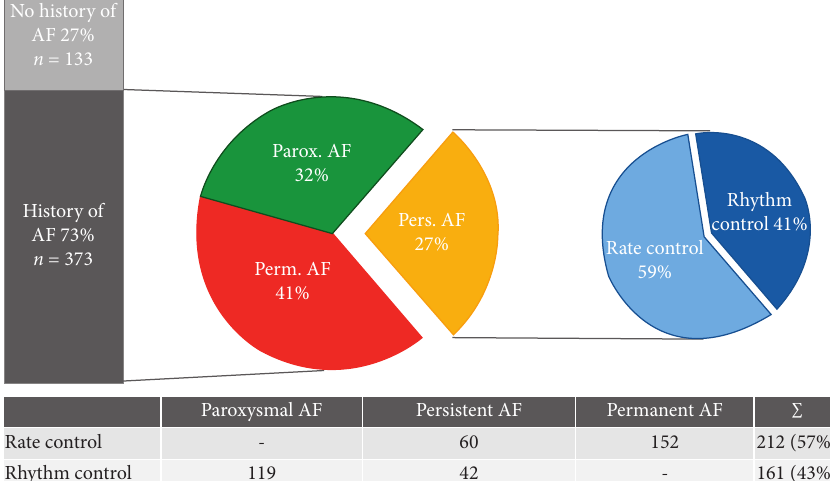
Figure 1: AF type and corresponding treatment regimes. Overview of patients with and without a history of AF, AF types, and cor- responding treatment regimes. AF, atrial fibrillation; Parox., paroxysmal; Pers., persistent; Perm., Table 3: Anticoagulation, CHA 2 DS 2 -VASc score, and AF treatment regimens with corresponding medication and interventions. Paroxysmal AF, n � 119